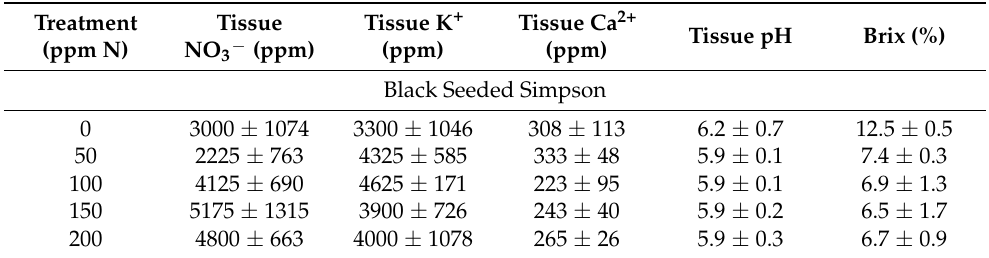
Table 2. Influence of nutrient concentrations on tissue mineral composition, pH, and solids content of four different lettuce cultivars grown hydroponic tub